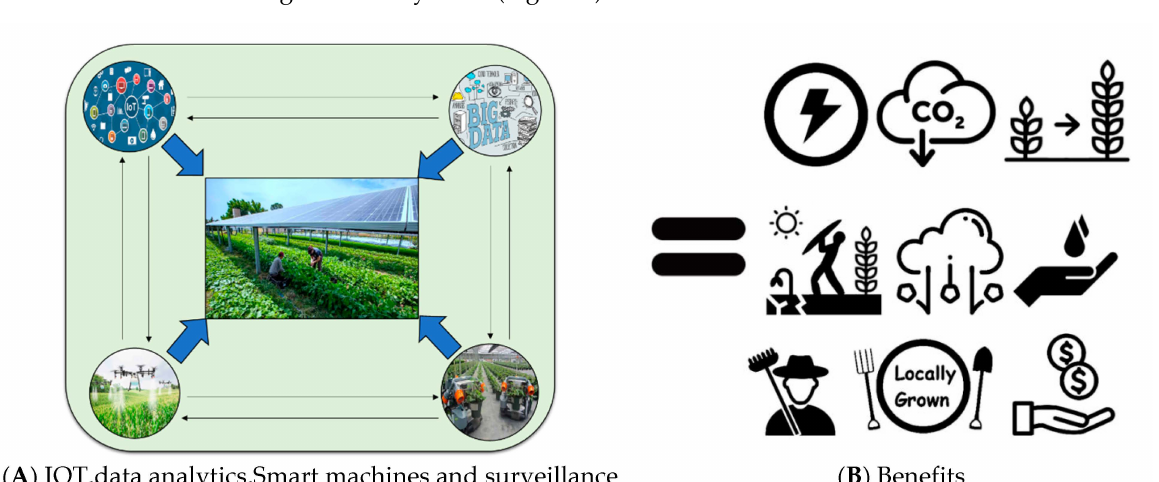
Figure 4. Smart agrivolatics